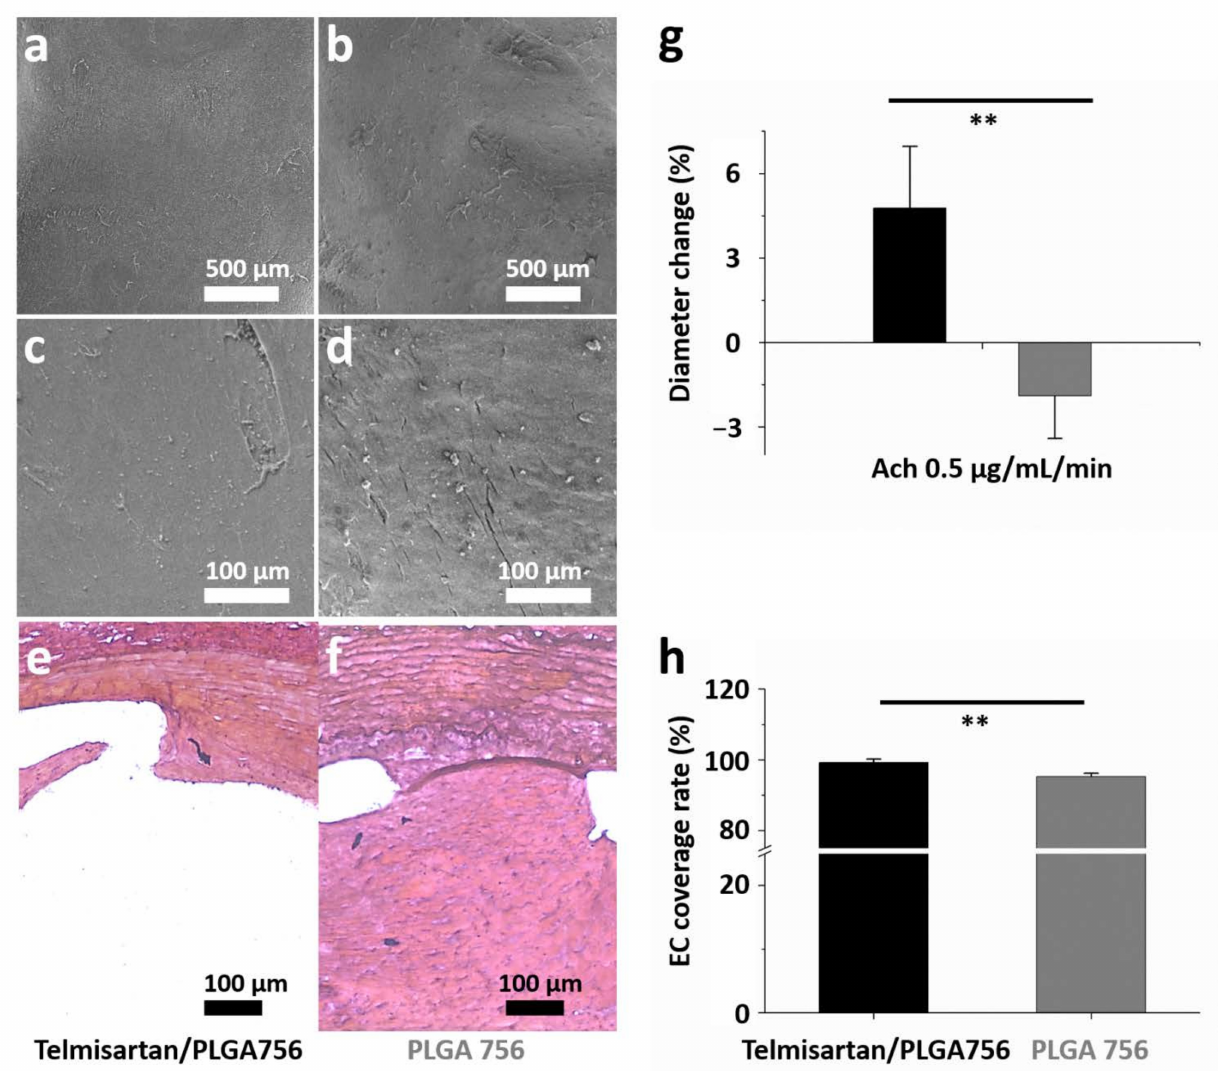
Figure 5. On day 28, the data were collected for (( a , b ), 35 × ; ( c , d ), 200 × ) morphology of endothelium under various magnifications and ( e , f ) response of intimal hyperplasia after four weeks of stenting treatment. ( g ) In vivo endothelial function was evaluated from variation in abdominal aorta diameter using acetylcholine (Ach) infusions. ( h ) Endothelium coverage in different groups. (** p <